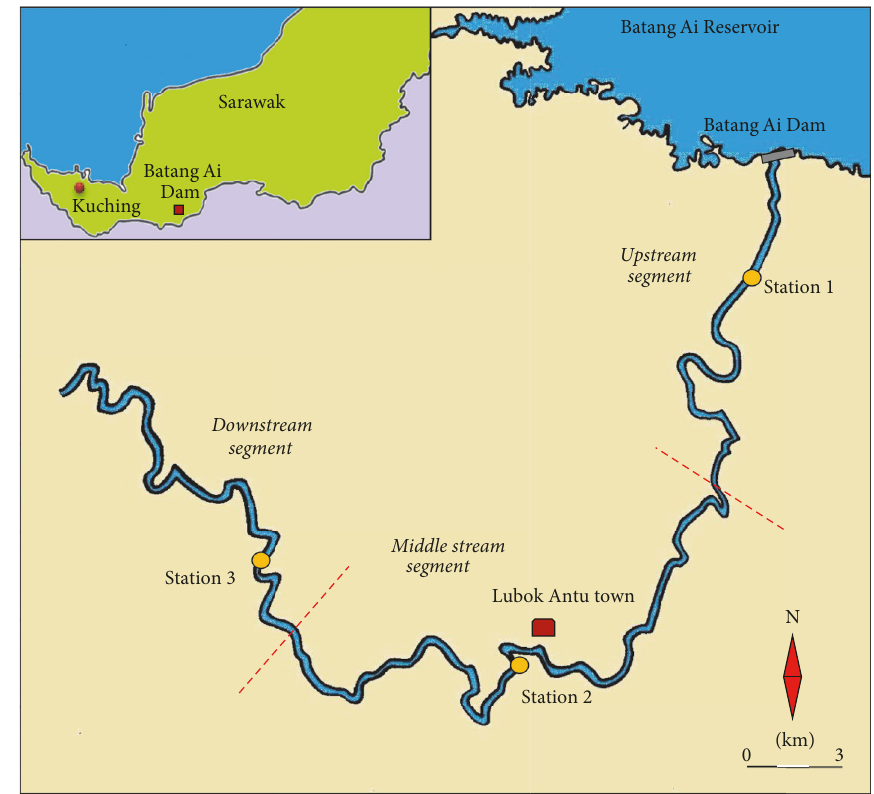
Figure 1: Location of the three segments and sampling stations in the study